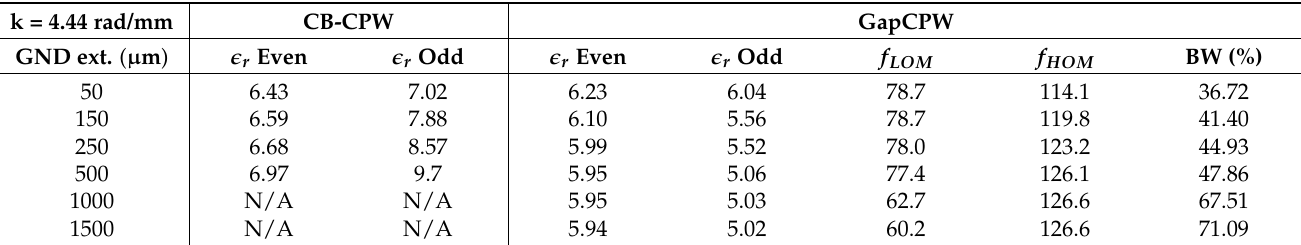
Table 1. Effect of the lateral ground